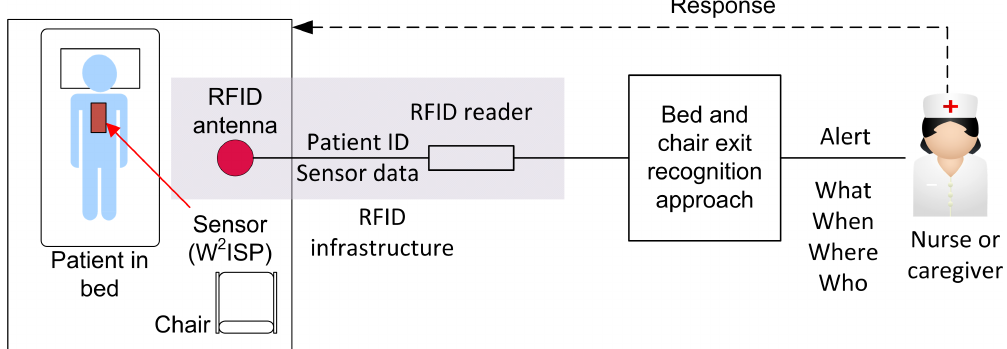
Figure 1. Overview of the proposed fall prevention technological intervention. Data collected by the radio frequency identification (RFID) infrastructure is sent in real-time to the bed and chair exit recognition approach stage. Caregivers can be notified via alert messages to assist the electronically identified patient ( who ) that is performing a bed or chair exit ( what ), the alert is issued in real-time ( when ) and the RFID antenna and reader identifiers can indicate the room occupied by the patient ( where